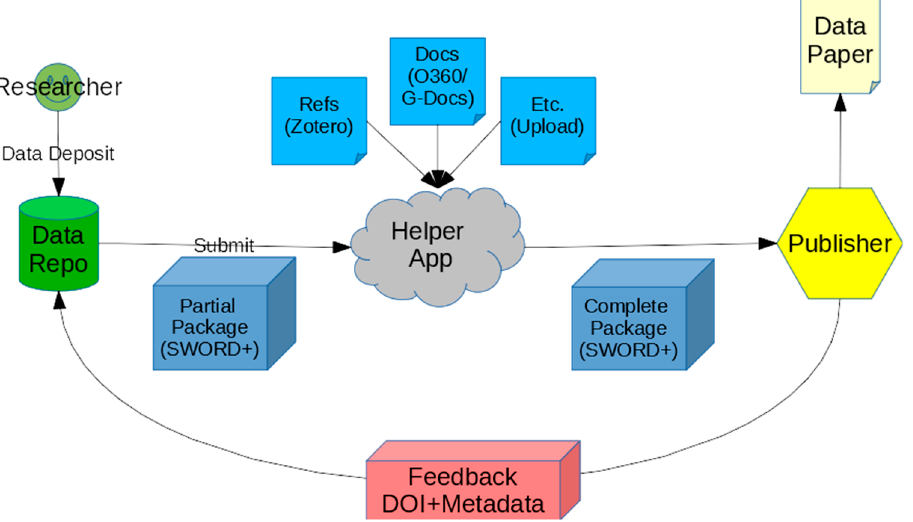
Figure 1. Straw-man Workflow for Helper App (as at Phase 1 pitching session in February 2015.).